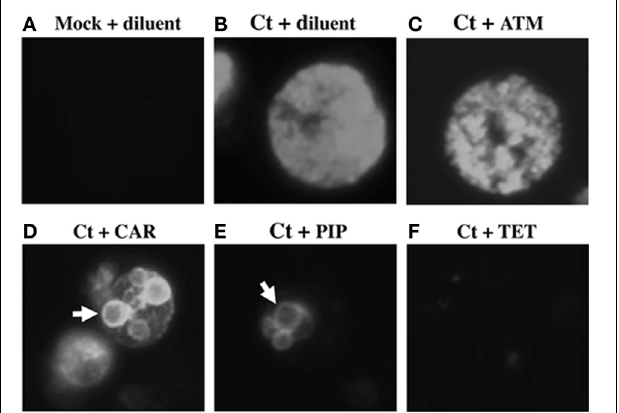
FIGURE 1 | Penicillin-exposure alters chlamydial morphology. HeLa cells were plated on glass coverslips, infected with C. trachomatis and refed immediately post-infection with growth medium + various dilutions of each antibiotic of interest. At 54hpi, infected cells were fixed and stained with FITC-conjugated anti- C. trachomatis MOMP as described. (A) Mock-infected cells + ddH 2 O (diluent). (B) C. trachomatis -infected (Ct)